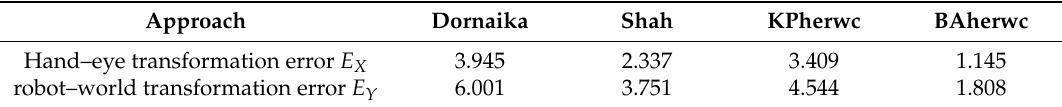
Table 3. Error comparison for the general object data set without a chessboard pattern as benchmark (Unit: